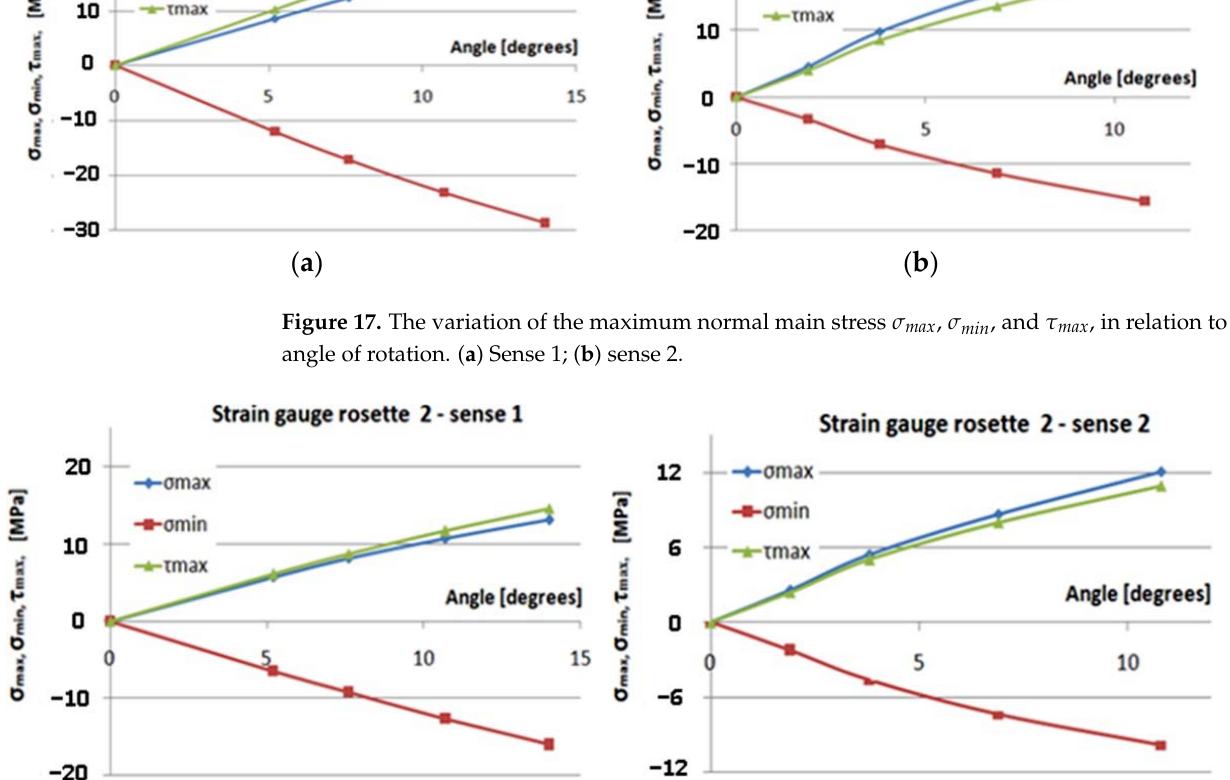
( b ) Figure 20. Gauge 4–sense 1,2: the variation of the maximum normal main stress σ max , σ min , and τ max , in relation to the angle of rotation. ( a ) Sense 1; ( b ) sense 2. In the finite element analysis (Figure 8), it was found that the highest value of the von Mises stress was obtained at the tip of the blade, corresponding to the location of the T4 transducer (Figure 11). Considering the von Mises relation: 𝜎 (cid:3049)(cid:3014) (cid:3404) (cid:3493)𝜎 (cid:3040)(cid:3028)(cid:3051)(cid:2870) (cid:3397) 3𝜏 (cid:3040)(cid:3028)(cid:3051)(cid:2870) , from the experiment, we deduce that: 𝜎 (cid:3049)(cid:3014) (cid:3021)(cid:2872) (cid:3404) (cid:3493)80 (cid:2870) (cid:3397) 3 (cid:3400) 60 (cid:2870) (cid:3404) 131.14 MPa (5) where the stresses calculated from the strains provided by the T4 transducer at a torque of 59.38 N ∙ m were approximately: σ max = 80 MPa and τ max = 60 MPa. It was found that close values of the von Mises stresses from the FEA and experiment were obtained, respec ‐ tively: AEF: torque: 60 N ∙ m, σ vM = 139.66 MPa; test: torque: 59.38 N ‐ m, σ vM = 131.14 MPa. From the static tensile loading of a specimen, made of same material as the blade and drawing of the characteristic diagram, a creep stress of about 430 MPa was obtained, so that the maximum stress observed, at any of the four transducers, was lower than the yield stresses. As mentioned above, the loading was performed in both directions. It has been found that there are differences in the angle of the rotation of the loading arm for the two loading directions. It is noted that the angle of rotation of the loading arm is equal to the angle of rotation of the free end of the blade. Thus, Figure 21 shows the variation of angle of rota ‐ tion of the boom, with the moment of torsion applied to the blade for the two load senses.